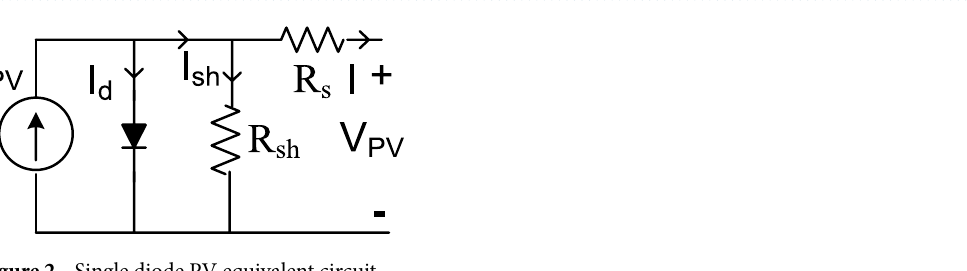
Figure 2. Single diode PV equivalent